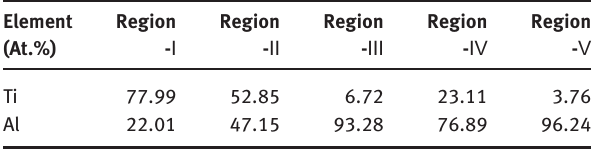
Table 1: EDS result of the mark positions in Figure